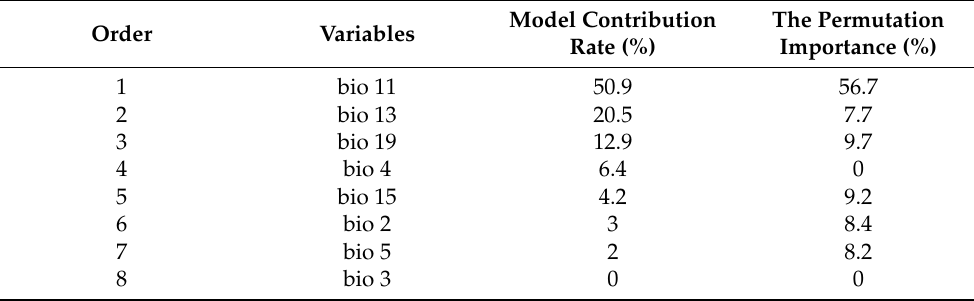
Table 6. The model contribution rate and permutation importance of